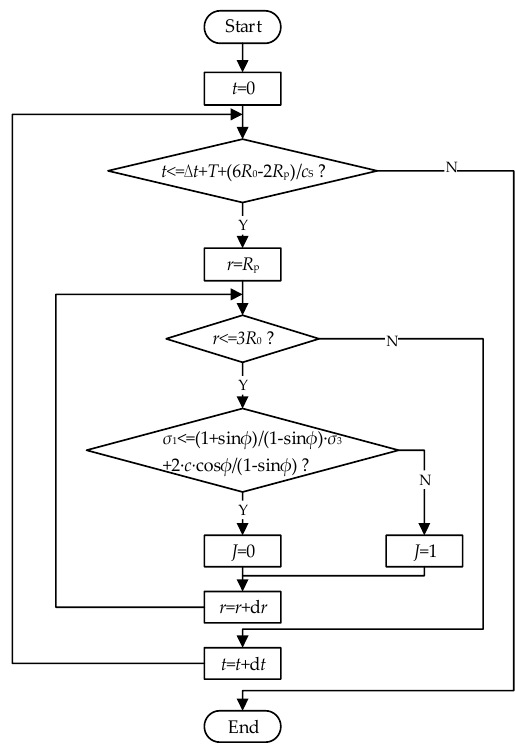
Figure 4. Flowchart for determining failures of unit bodies of coal-rock masses.